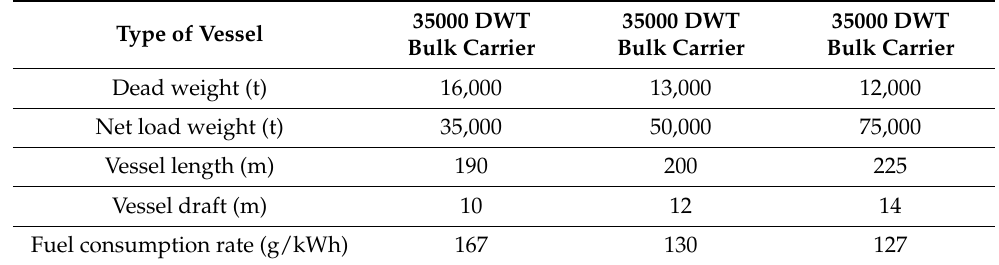
Table 2. Specifications of the different types of vessels used in the simulation.